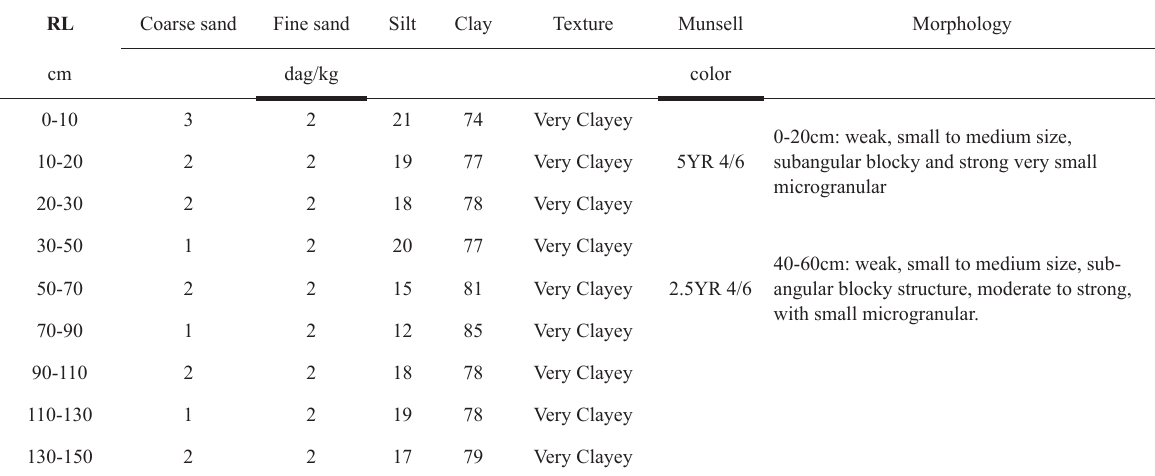
Physical and morphological attributes of Red Latosol (RL) under Dystrophic Cerradão (woodland) in Paraopeba National Reserve.